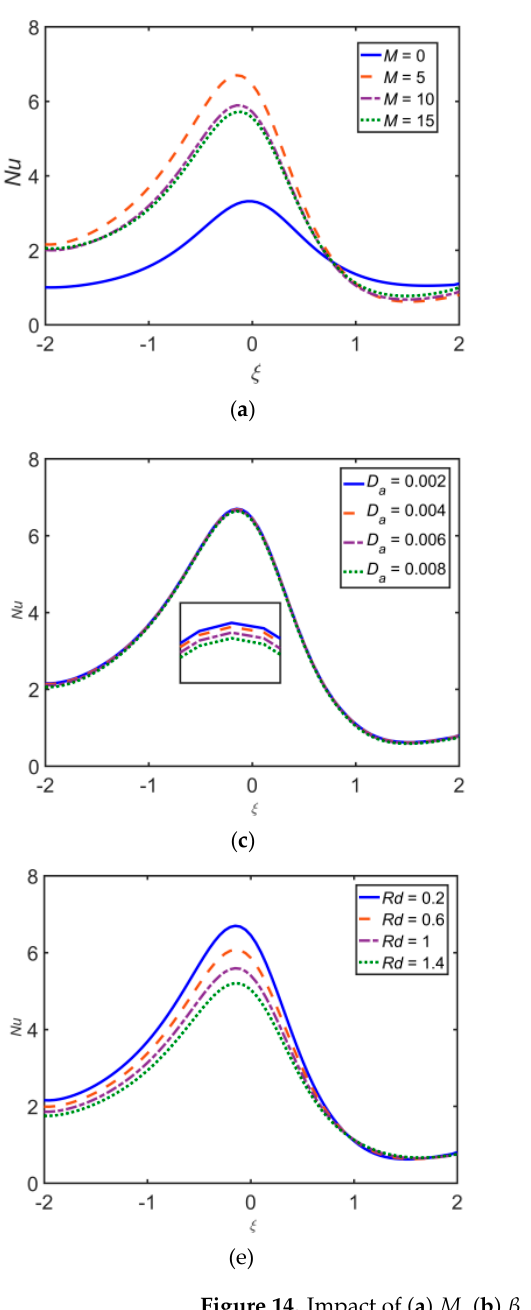
Figure 13. The 𝜑 profile at ( a ) 𝑥 = 0 and ( b ) 𝑥 = 2 for distinct values of 𝑆𝑟 .